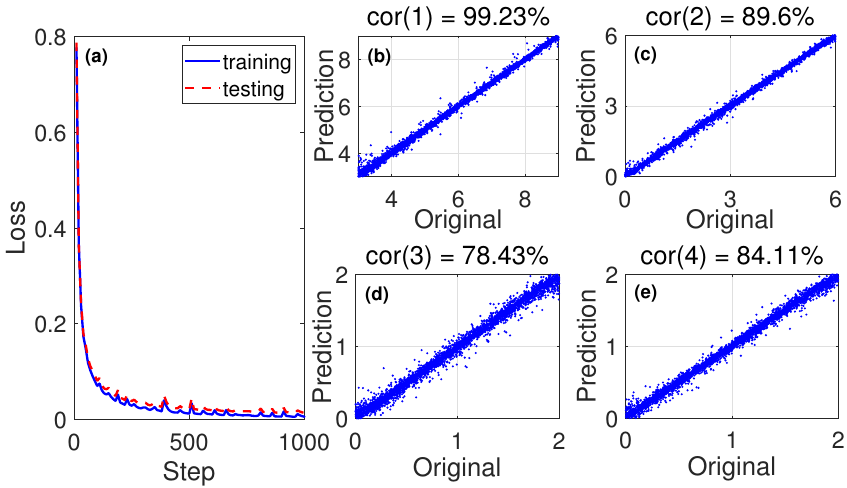
Figure 3. ( a ) The loss of the training and testing processes. Both training and testing losses converge to a very small value rapidly at the beginning of the training process. ( b – e ) show the precision rate of four band parameters, respectively. We can see that rp 1 , the band gap, has the highest accuracy.